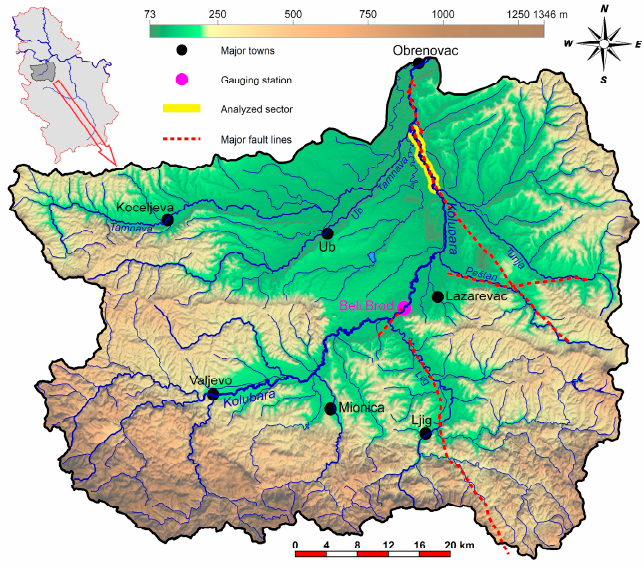
Figure 1. Study area: the Kolubara River Basin in Serbia.